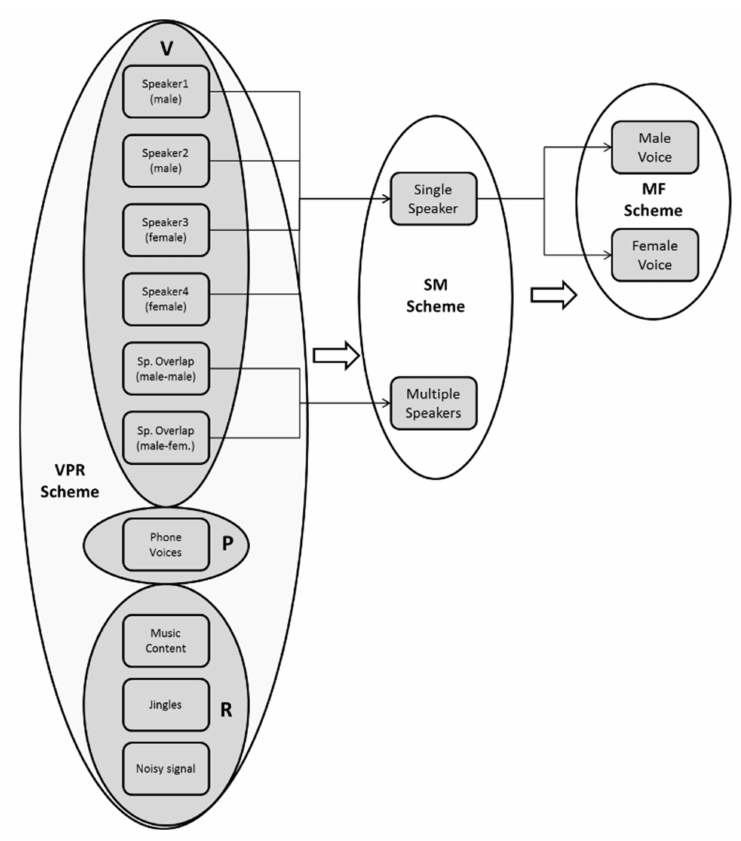
Figure 2. Proposed classification